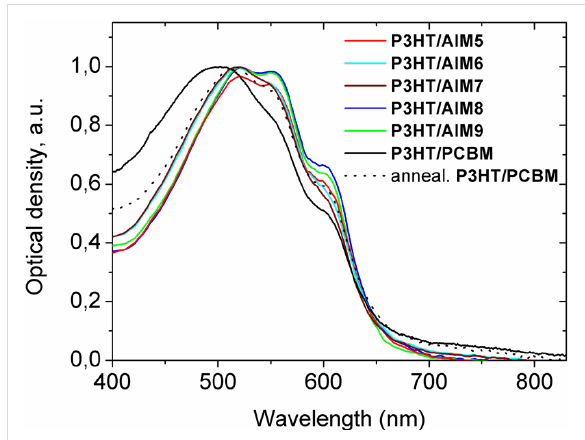
Figure 5: Absorption spectra of P3HT/fullerene blended films. The P3HT/PCBM blend was annealed during 15 min at 130 °C.